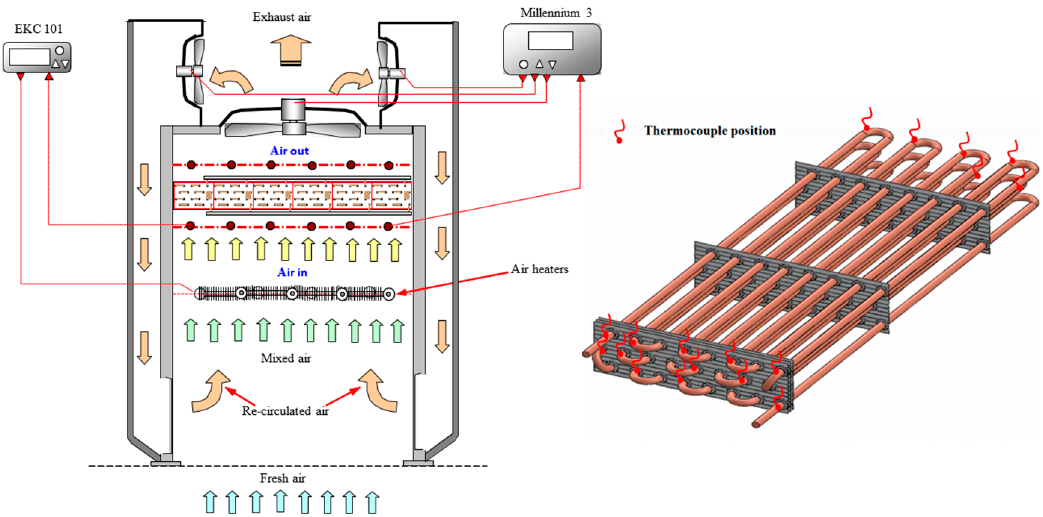
Figure 4. Gas cooler test rig and thermocouple positions. Table 1. Comparison of modelling results with experimental data [11].